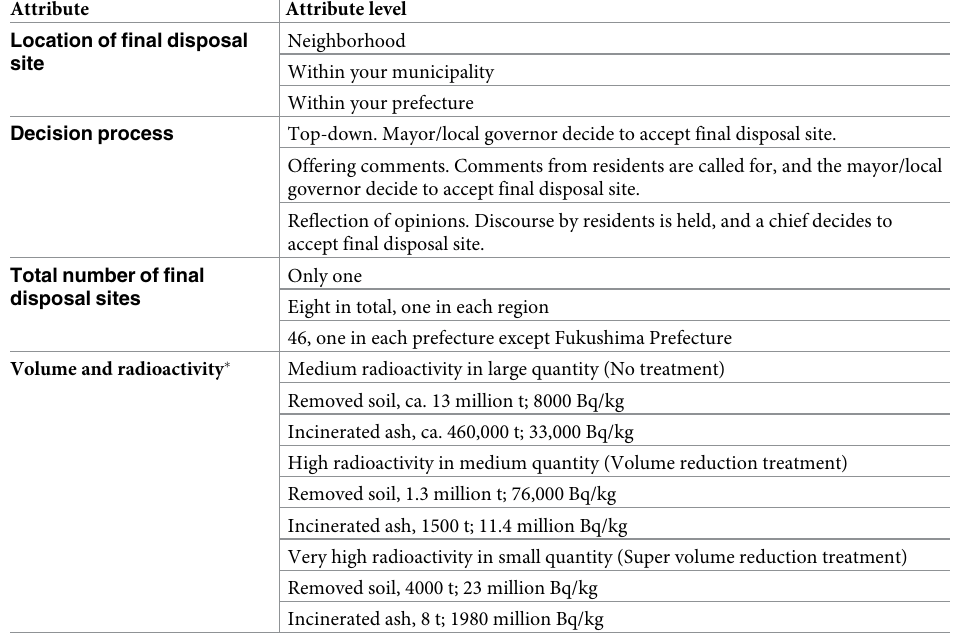
Table 2. Conjoint attributes and attribute